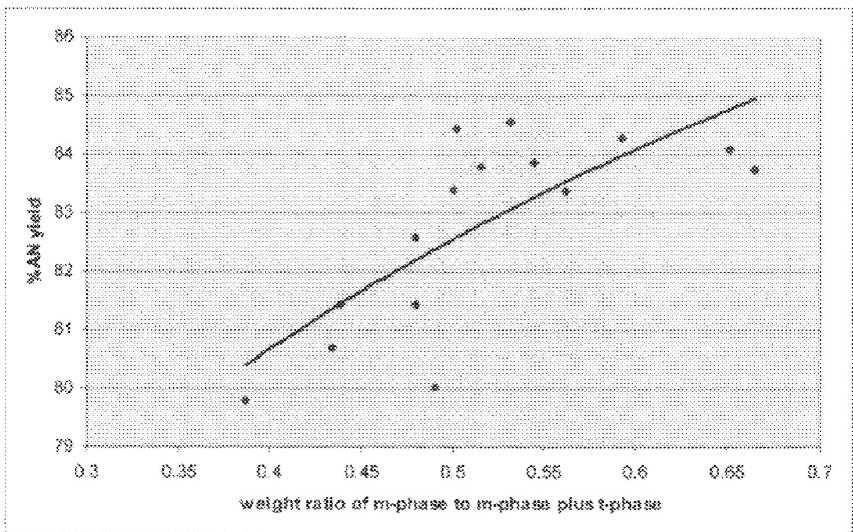
Figure 3. Rietveld X-ray diffraction analysis of cerium-containing mixed metal oxide acrylonitrile catalyst where m-phase (Ce 2 (MoO 4 ) 3 ) and t-phase refer to the monoclinic and tetragonal forms of the scheelite structure, respectively [49].